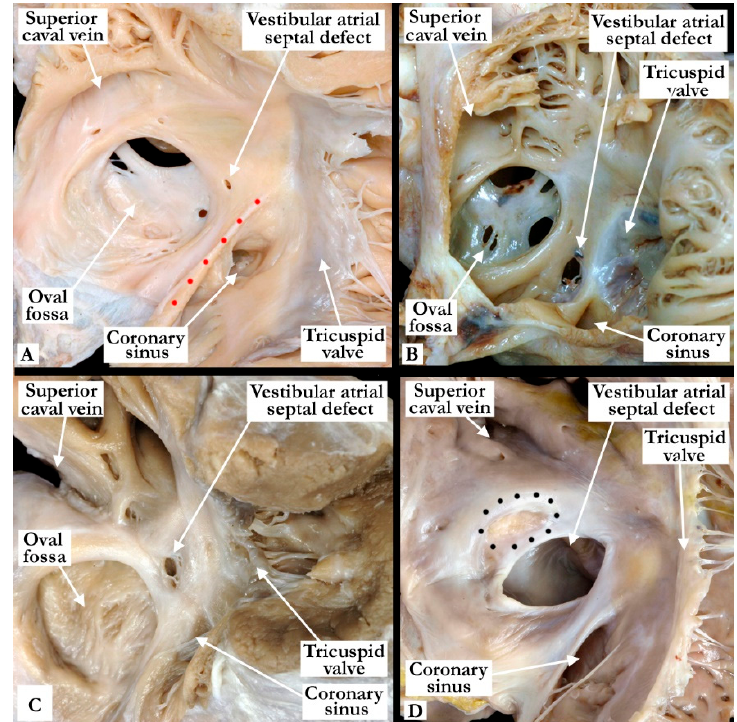
Figure 2. The images show the variations in size and position of vestibular atrial septal defects. In (Panel A ), we show a small defect within the antero-inferior rim of the oval fossa. There is also a fenestrated flap valve at the floor of the oval fossa. The Eustachian valve (red dots) is prominent in this specimen. In (Panels B,C ), the defects are larger and focally fenestrated with the defect shown in (Panel B ) in a more inferior position, while the defect seen in (Panel C ) is toward the most superior extent of the margins of the true atrial septum. There is an intact flap valve in the heart shown in (Panel C ), and a fenestrated flap valve at the floor of the oval fossa in the heart seen in (Panel B ). In (Panel D ), we show an exceedingly large vestibular defect. This was an incidental finding at autopsy in a 46-year-old patient who died secondary to a stroke. It was approximately 2 cm in diameter. The borders of the oval fossa are marked with black dots and the foramen was closed.